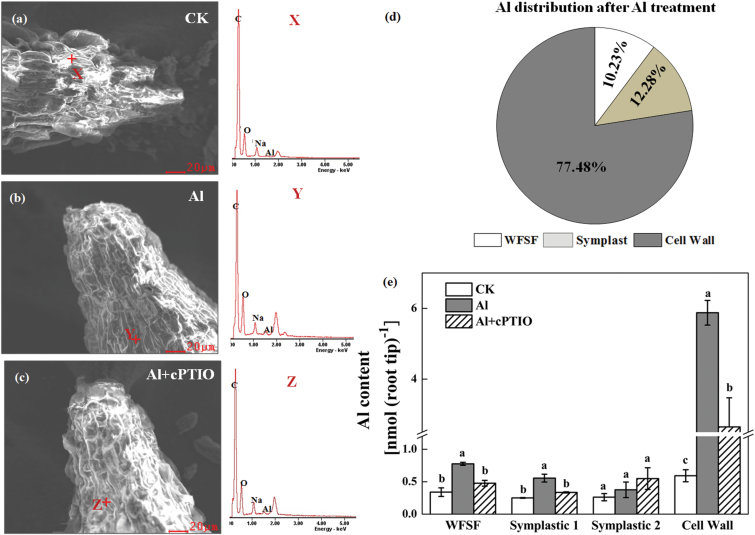
SEM-EDS spectra and Al compartmentation in wheat root apices (10mm). Representative images of SEM and EDS spectra without Al (a), with Al (b), and with Al and cPTIO treatment (c) are given. Relative distribution of Al (d) and Al contents (e) of cell walls, symplast, and WFSF. Wheat seedlings were exposed to 0.5mM CaCl2 solution containing 30 μM Al with or without 30 μM cPTIO for 24h. The relative distribution of Al was only calculated for roots treated with Al alone. Data are means ± SD (n = 3). Means with different letters are significantly different at P < 0.05.